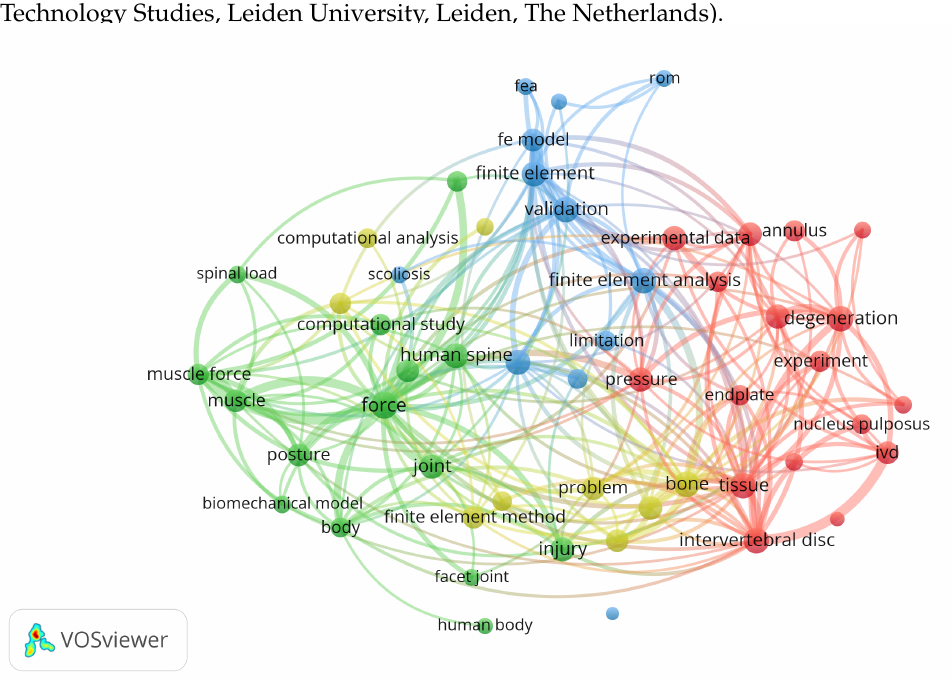
Figure 2. Network visualization for title, abstract, and